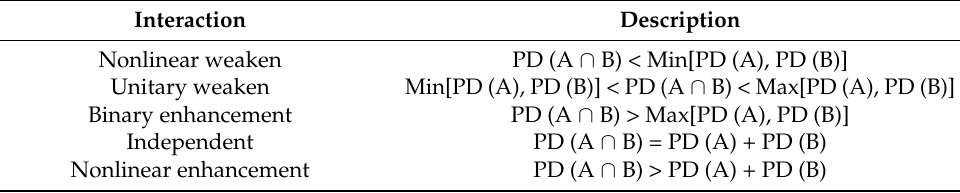
Table 3. Types of interaction between two